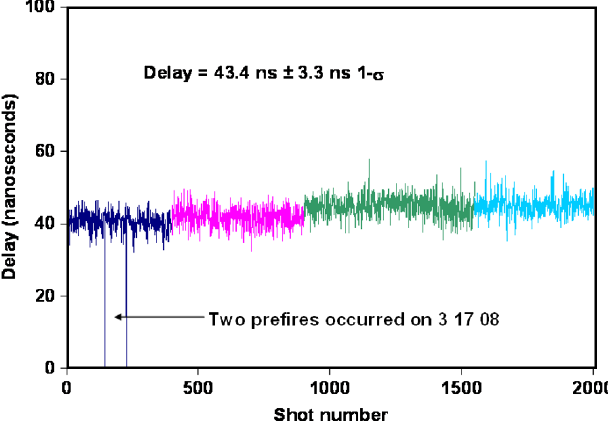
FIG. 17. (Color) Lifetime testing results for the Kinetech switch. This switch was operating at 68% of its self-breakdown voltage. Data was taken on four successive days.